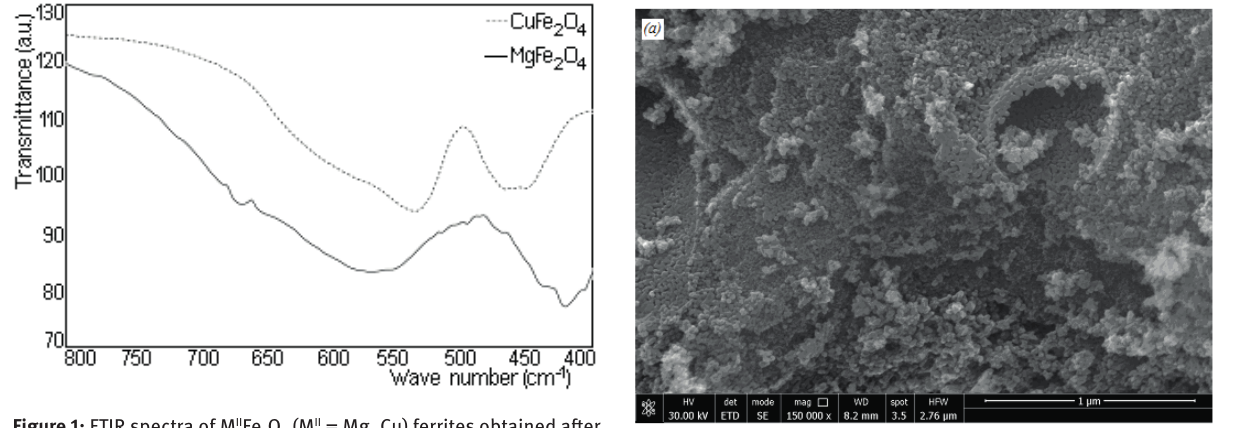
Figure 1: FTIR spectra of M II Fe the calcinations at 500⁰C for 1h of the coordination compounds.